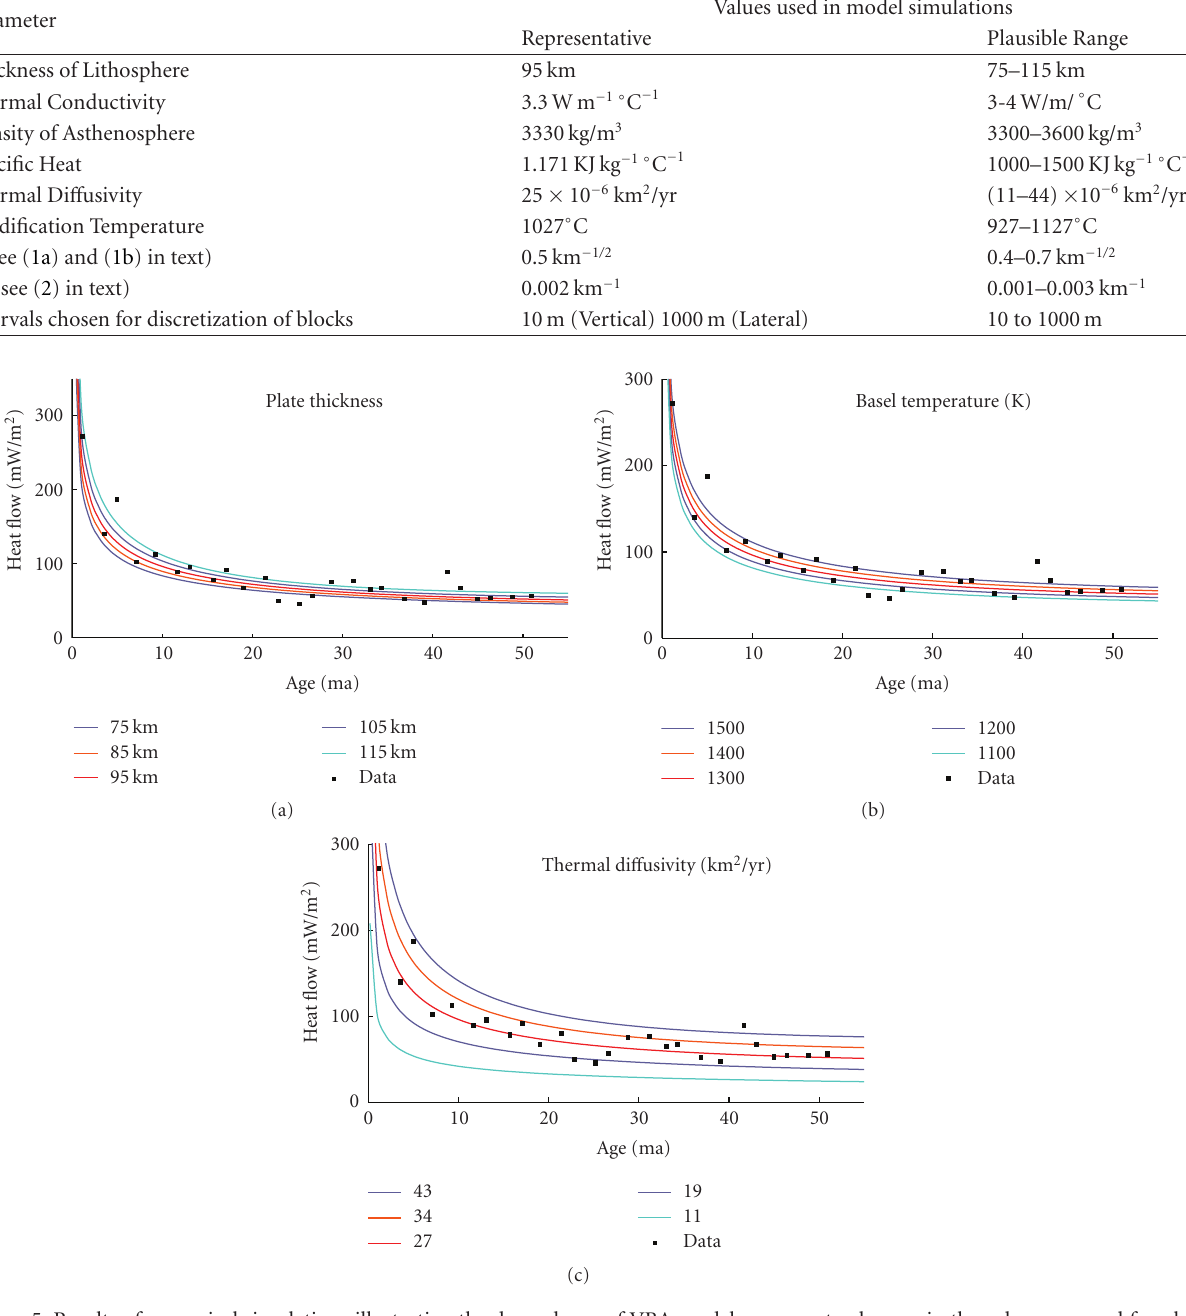
of some of the numerical simulations are illustrated in the set of panels in Figure